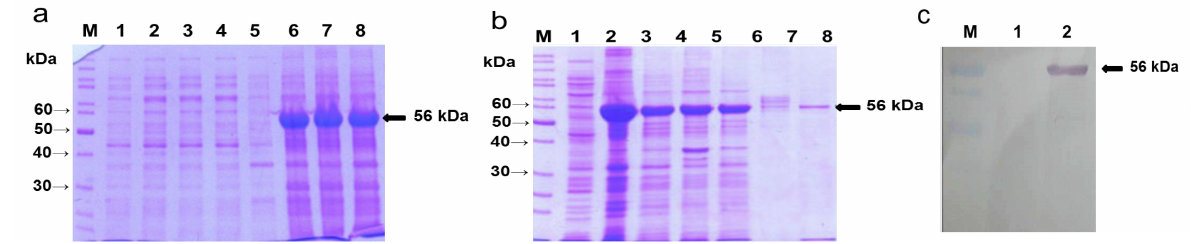
Figure 1. Overexpression of the A . nidulans phy gene in E . coli , purification of the Phy-6× His-tagged fusion protein and production of the recombinant protein (rPhy-E)-specific antibody. ( a ) After 4 h induction with IPTG, soluble (Lanes 1–4) and insoluble (Lanes 5–8) fractions of bacterial lysates were compared on 10% SDS-PAGE. A prominent band of the electrophoretic mobility (56 kDa) on SDS-PAGE was observed in the insoluble fractions of the bacterial culture. Lane M, protein marker; Lane 1, soluble protein of E. coli BL21(DE3) containing the pET-28a vector only; Lanes 2–4, soluble protein of E. coli BL21(DE3) containing pET-phy induced with IPTG at 1, 3 and 5 mM; Lane 5, insoluble protein of E. coli BL21(DE3) containing the pET-28a vector only; Lanes 6–8, insoluble protein of E. coli BL21(DE3) containing pET-phy induced with IPTG at 1, 3 and 5 mM; ( b ) The rPhy-E fused with 6× His-tag was purified from E. coli BL21(DE3) by affinity chromatography; ( c ) Western blot analysis of rat antibody is able to recognize the rPhy-E in total protein extracted from bacterial